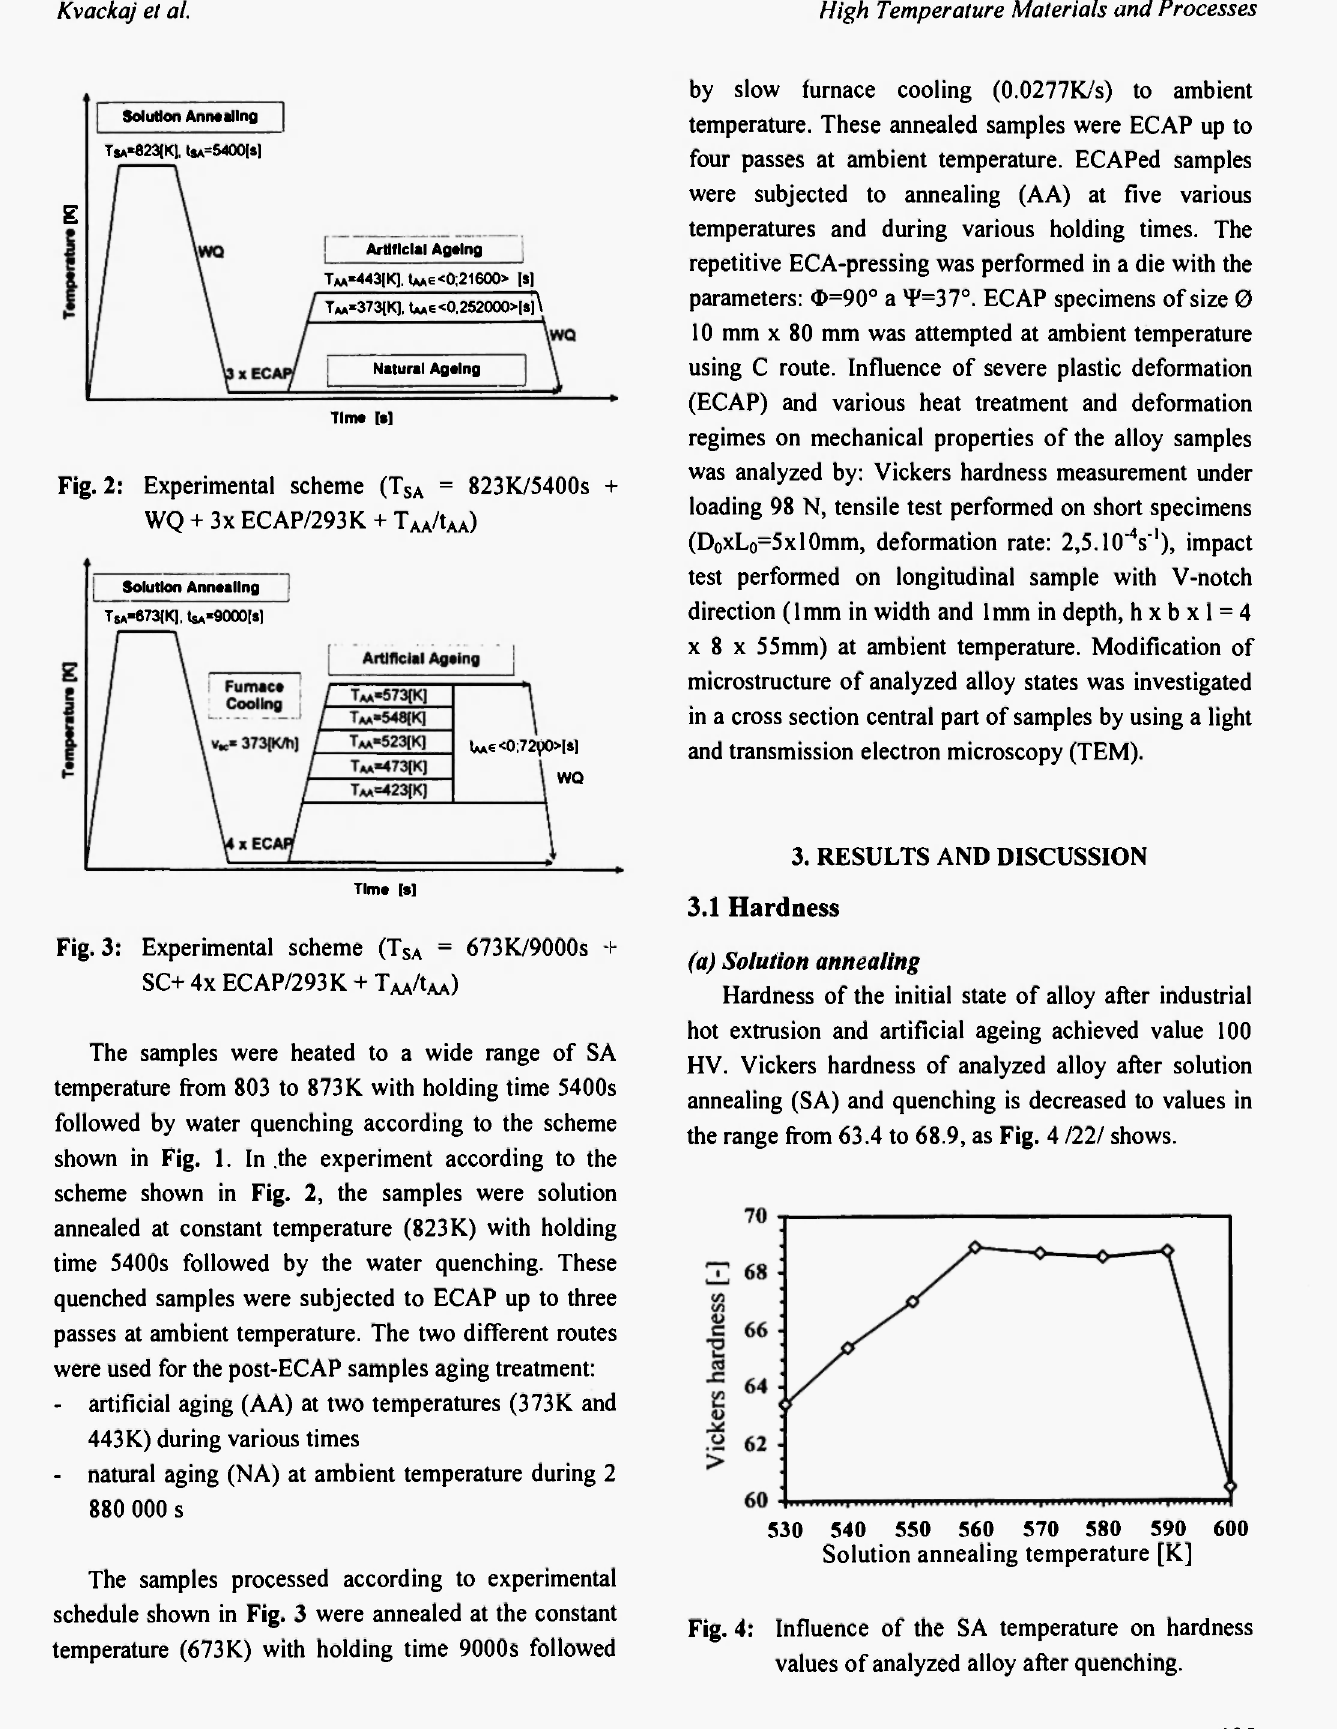
Fig. 4: Influence of the SA temperature on hardness values of analyzed alloy after